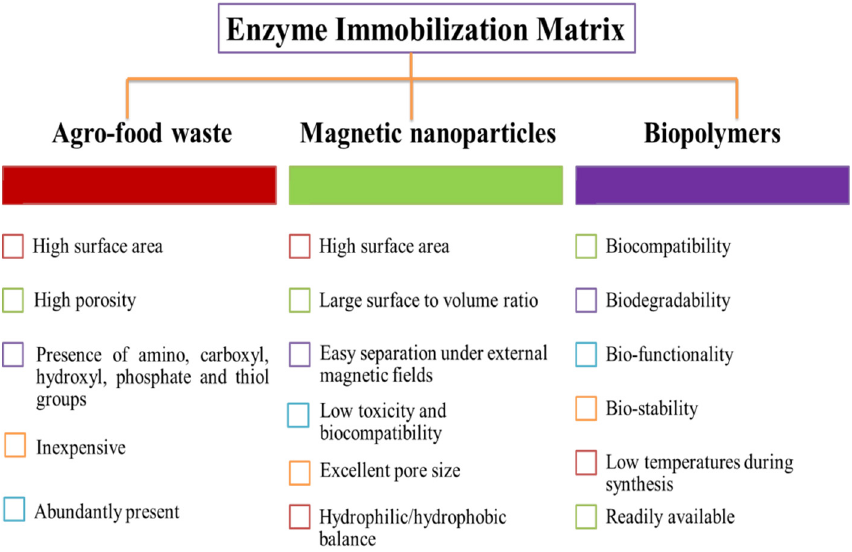
Figure 4. Properties of different enzyme immobilization matrixes.